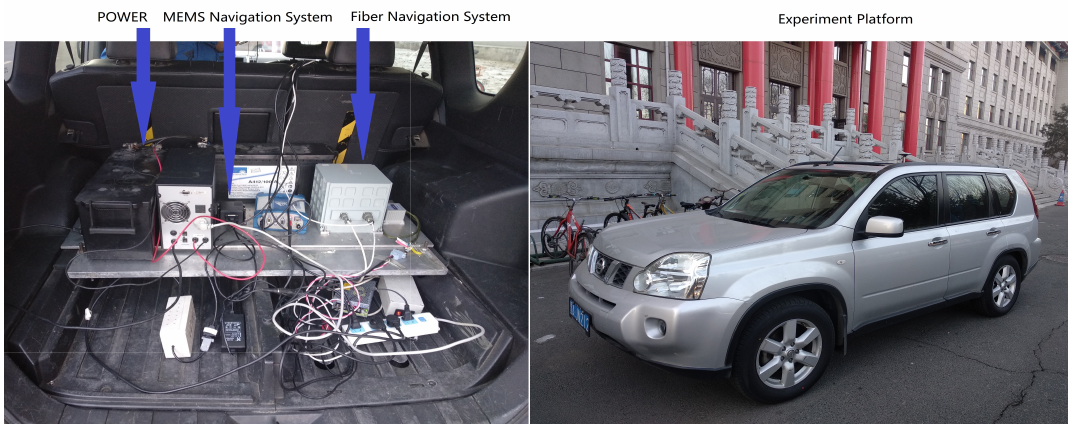
Figure 2. Experiment platform